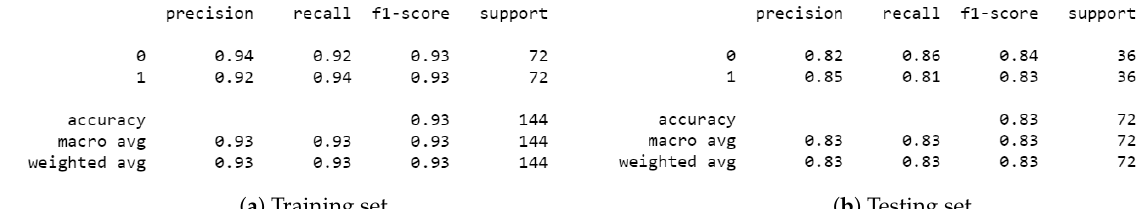
Figure A9. Classification